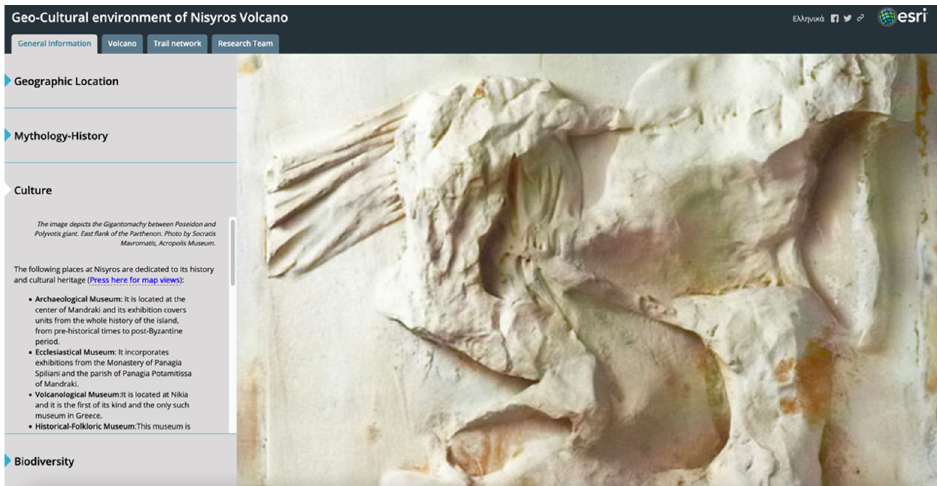
Figure 9 . Screenshot showing part of the narration about the cultural heritage of the island accompanied by a photo depicting the Gigantomachy between Poseidon and Polyvotis giant.